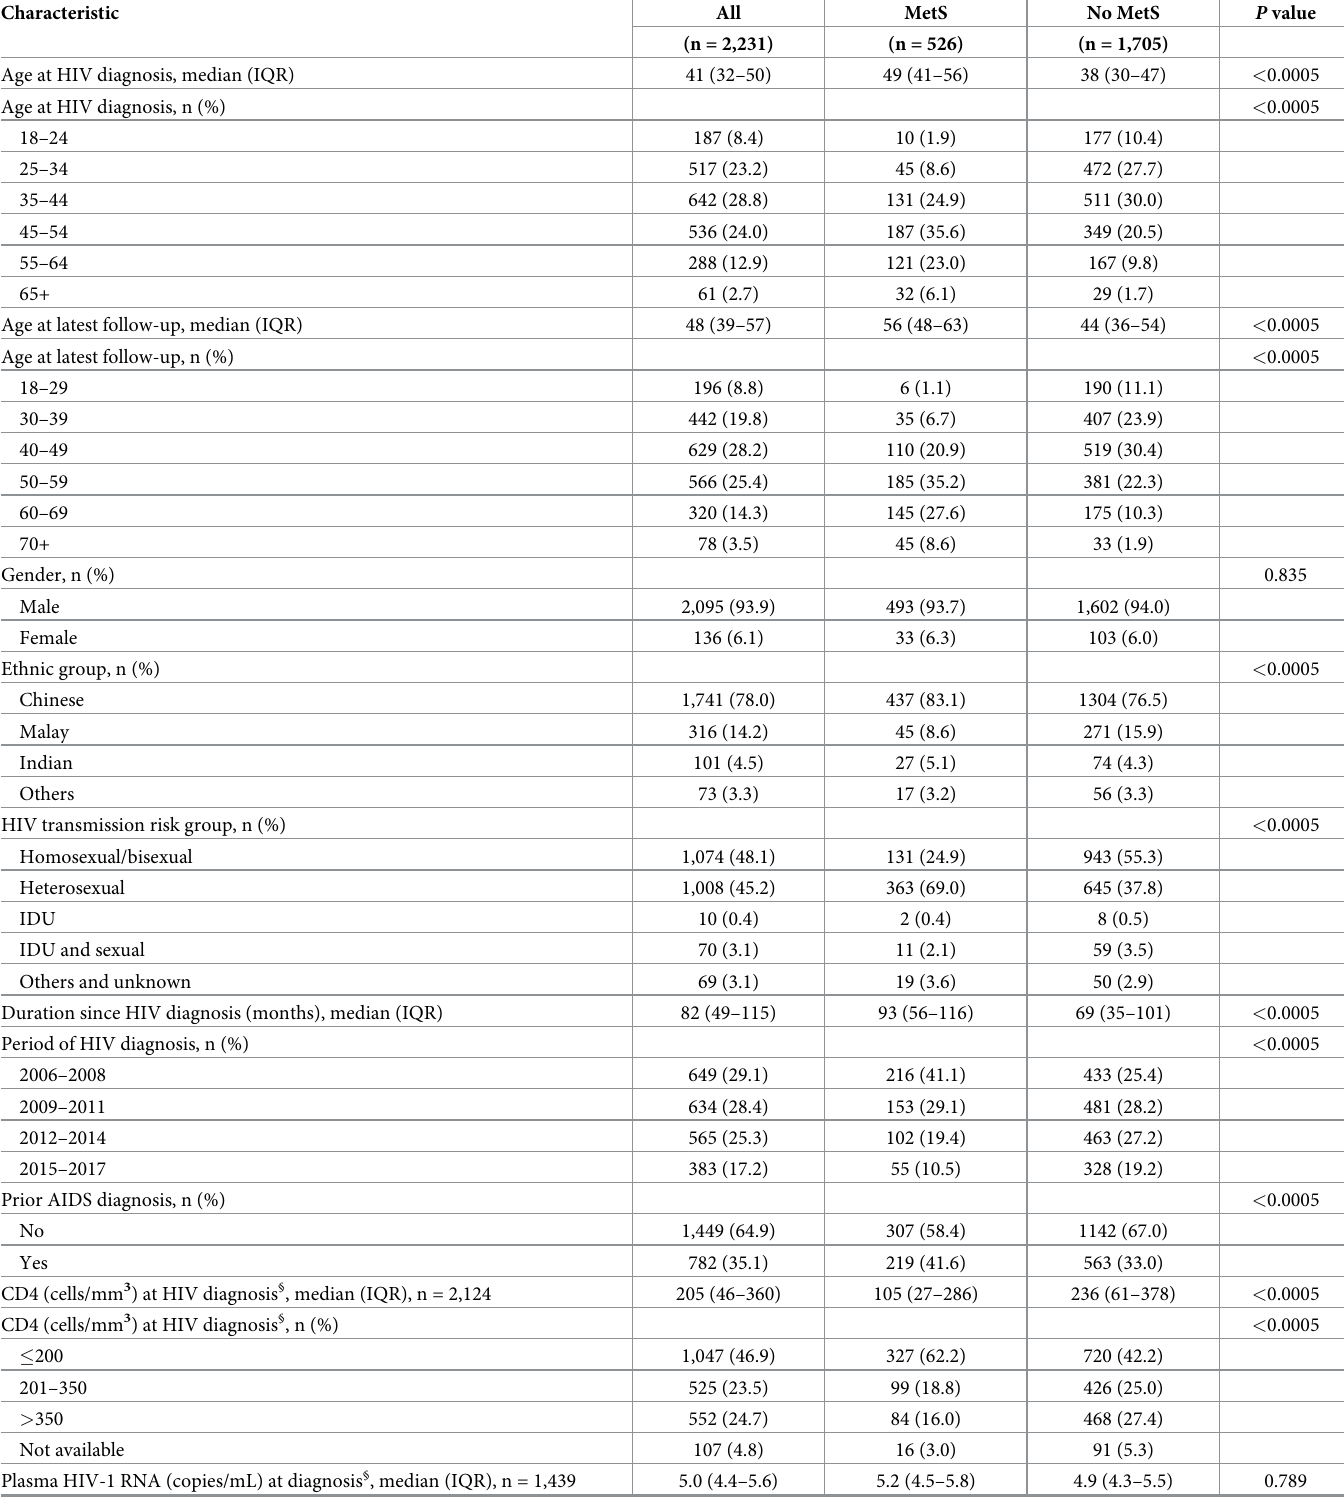
Table 1. Epidemiological and clinical characteristics of people living with HIV on follow-up between 2015 and 2017 by status of metabolic syndrome.